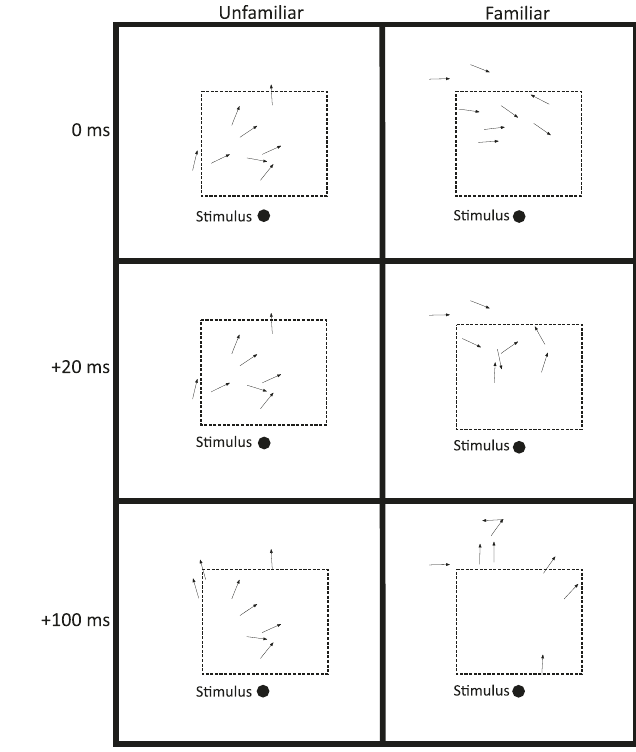
Fig. 6 Example school behaviour after stimulation. Each arrow shows the position and orientation of one fi sh. Successive frames from top to bottom illustrate the school ’ s cohesion and alignment at 0 ms (the moment immediately before stimulation), + 20 ms (during the escape response), and + 100 ms (following the escape response) post-stimulation. The experimental arena measured 50 cm (long) × 40 cm (wide), with directional fl ow from right to left in the illustration. Both illustrated schools were stimulated by the right lateral stimulus, with an identical lateral stimulus on the left side of the arena, relative to the directional fl ow (both 2 cm from each of the lateral walls in the centre of the swim tunnel). To control for a stimulus side preference, the use of the left or right lateral stimulus was alternated between